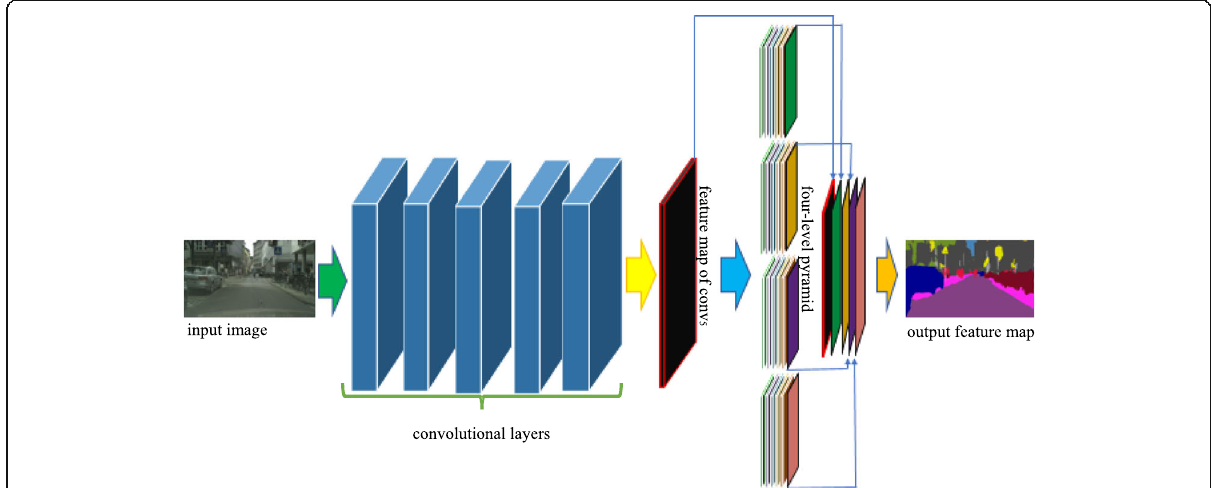
Fig. 1 Spatial pyramid pooling model. Four layers of pyramids are paralleled and feature extraction after the atrous convolution, and finally the information of the aggregated context is cascaded and